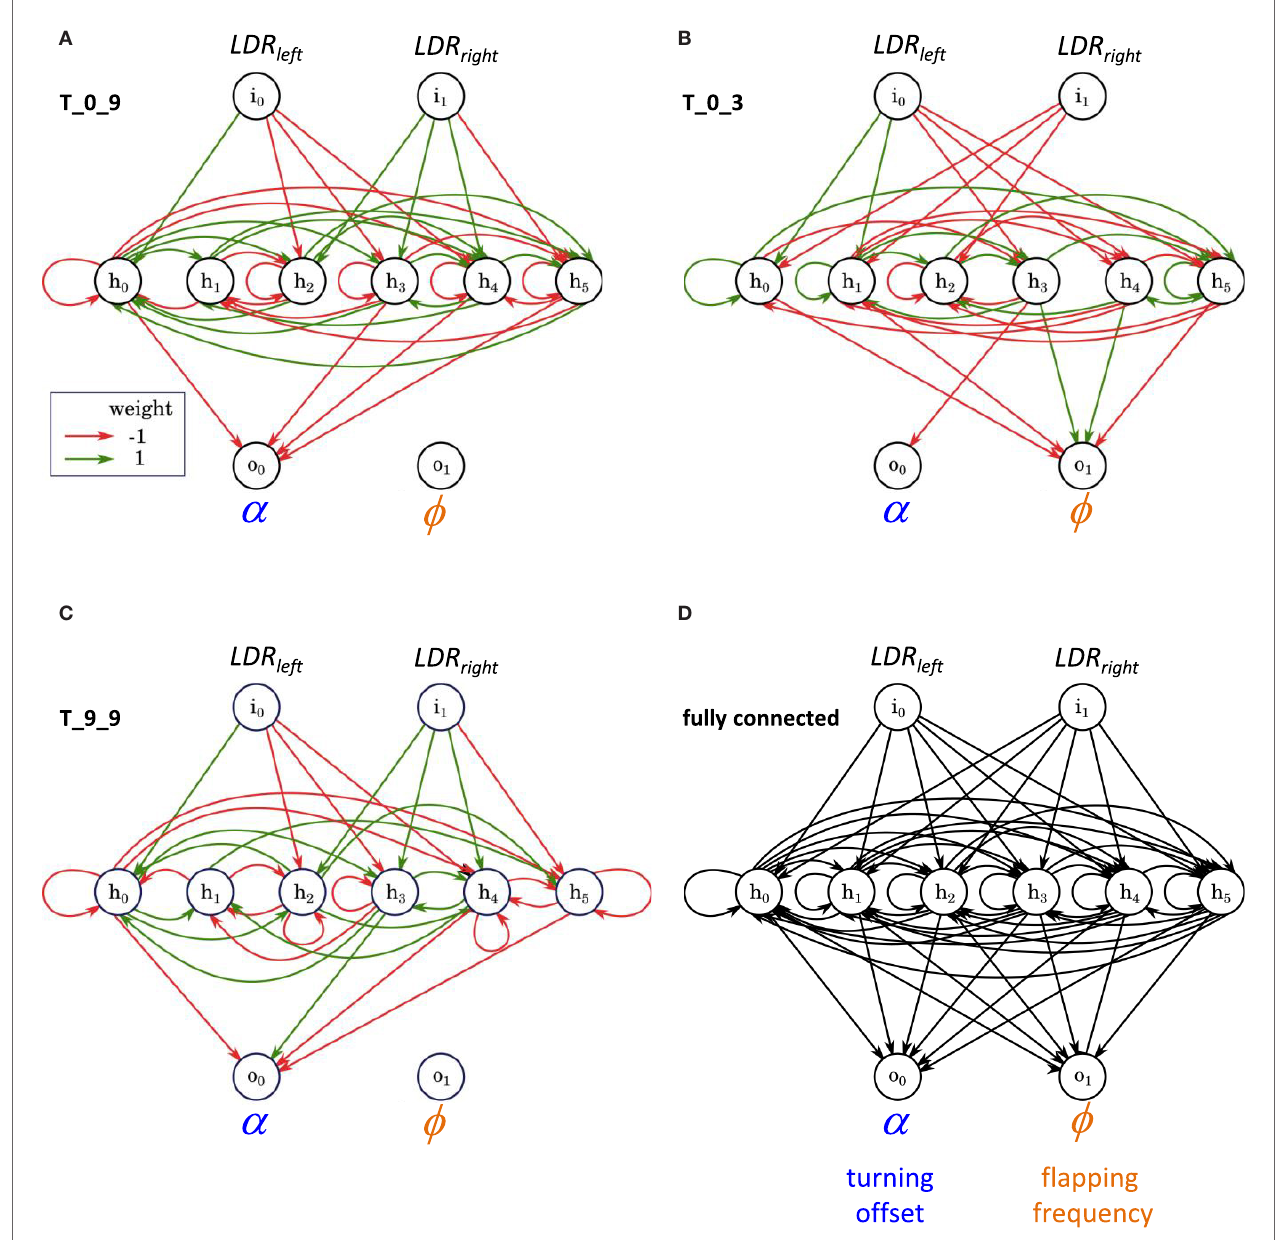
FigUre 10 | The structure of random and evolved anns, examples . (a–c) Same individuals used in Figures 4 , 5 and 9 . (D) A fully connected ANN for